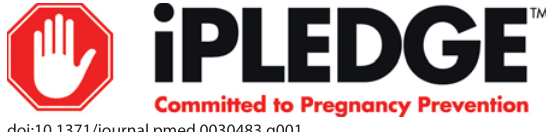
Figure 1. The iPLEDGE